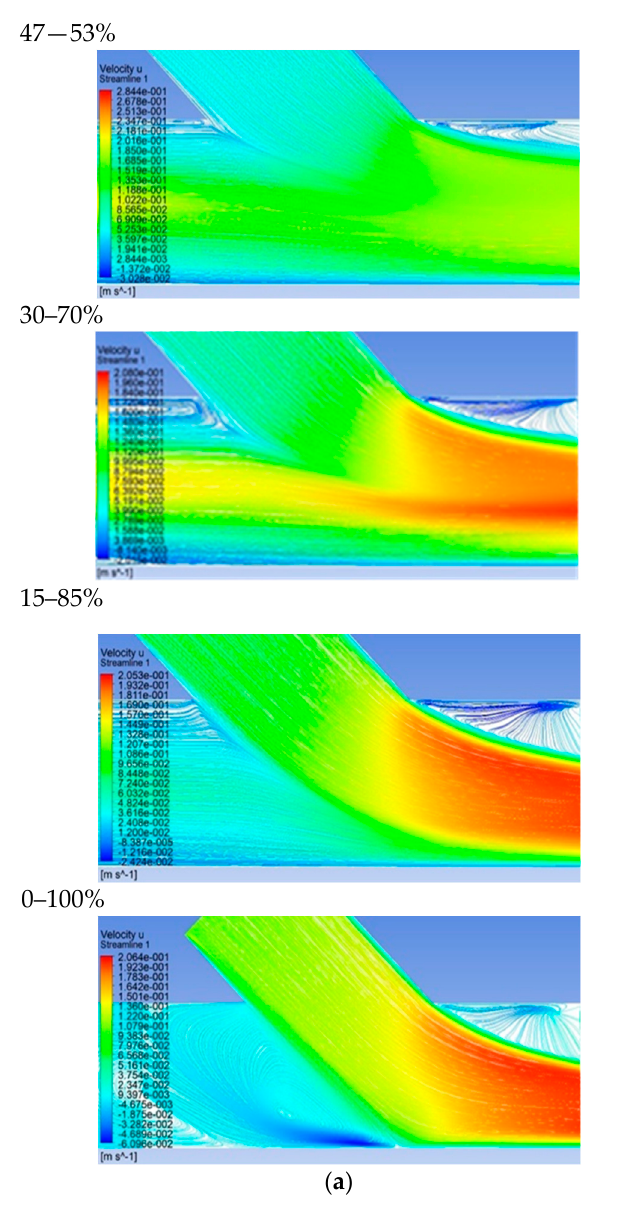
Figure 10. Comparison between computational and experimental visualization results in the anas- tomosis region ( a ) Computational results of the longitudinal velocity component, ( b ) experimental visualization results.